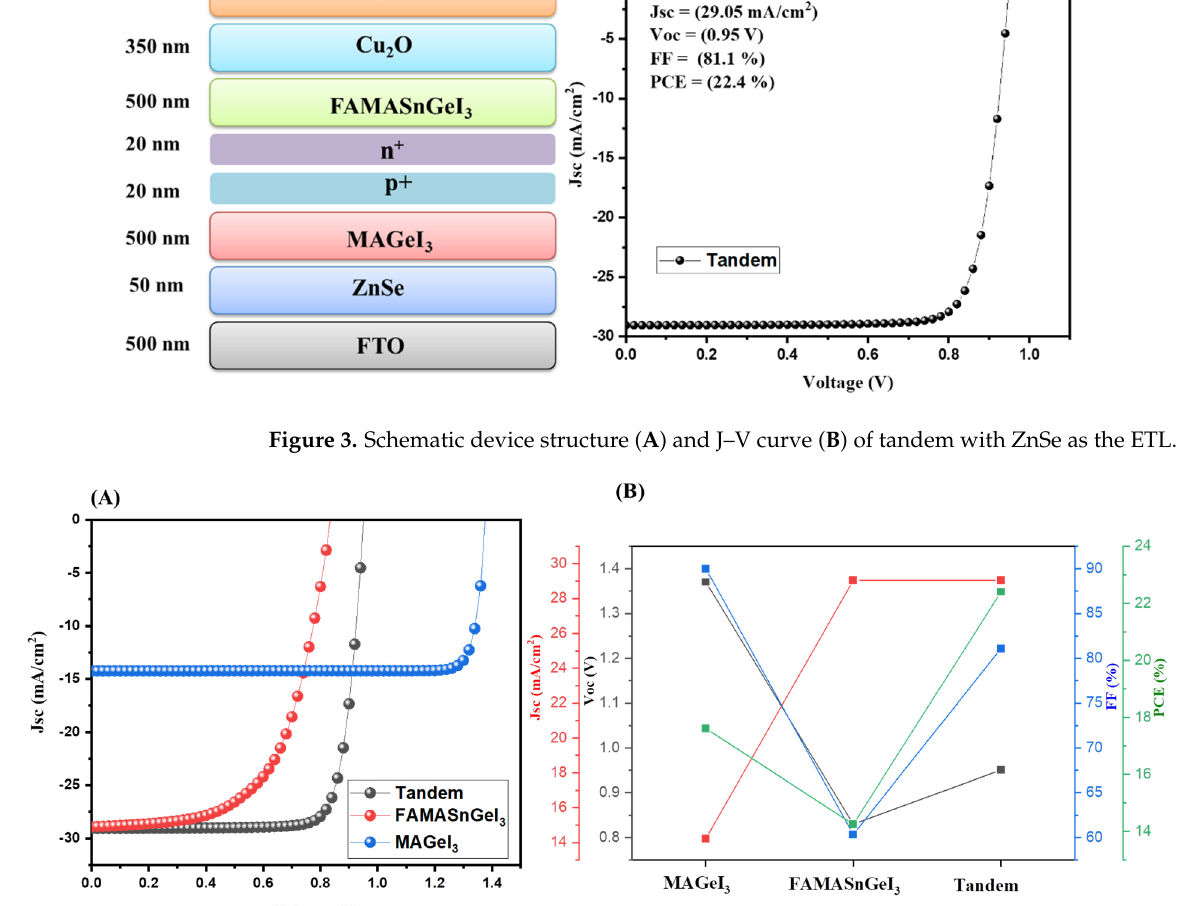
Figure 3. Schematic device structure ( A ) and J–V curve ( B ) of tandem with ZnSe as the ETL.